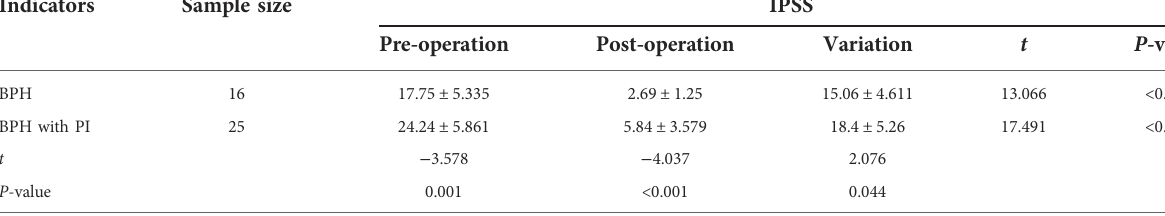
TABLE 3 Comparison of IPSS data between two groups before and after surgery (mean±SD).